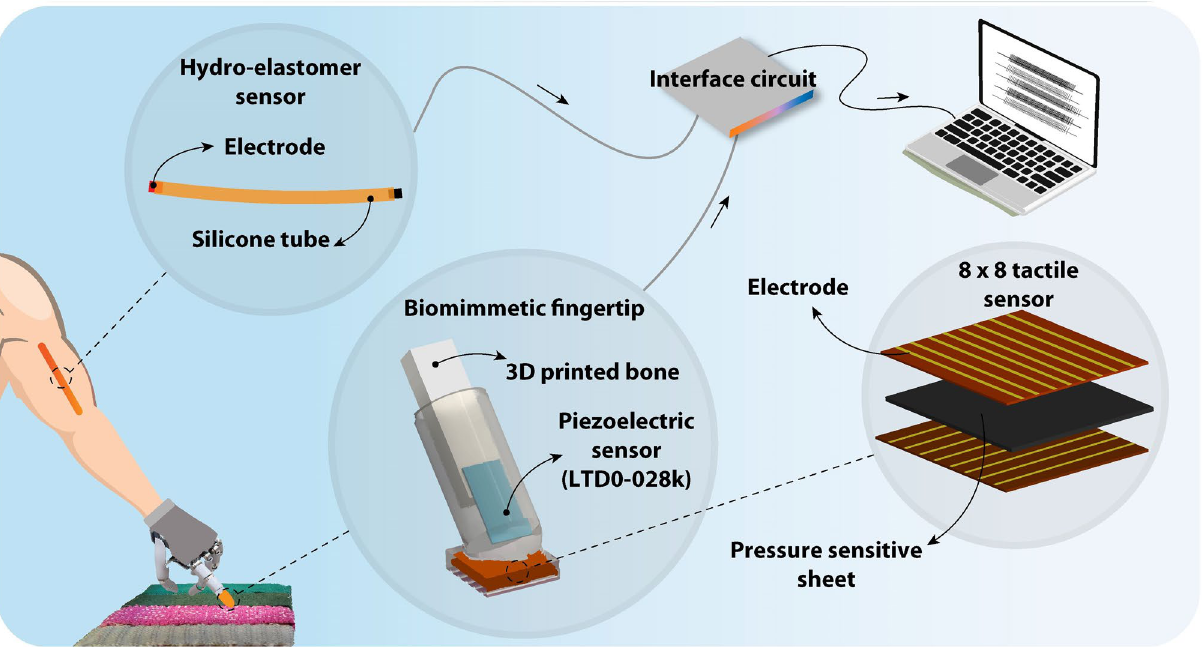
Figure 2. The schematic of the proposed multi-channel neuromorphic system. The artificial sensors on the prosthetic finger transduces contact and motion events during texture scanning to spiking responses. The detailed structure of the biomimetic fingertip and hydro-elastomer sensor are also shown. The 8 × 8 tactile sensor for mimicking SA-I/RA-I afferents to sense static/dynamic skin indentation. The piezoelectric sensor